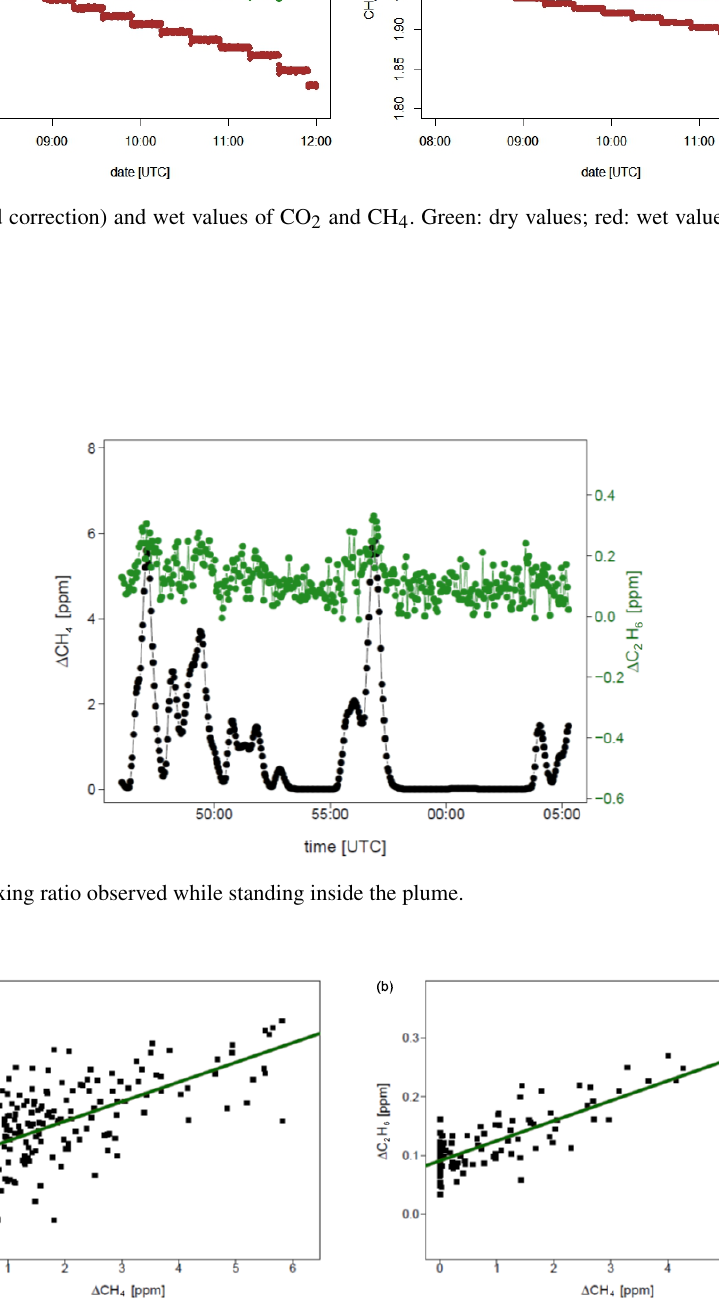
Figure B2. C 2 H 6 mixing ratio vs. CH 4 mixing ratio observed while standing inside the plume. (a) Non-averaged data, (b) 10s averaged data. Green line: linear